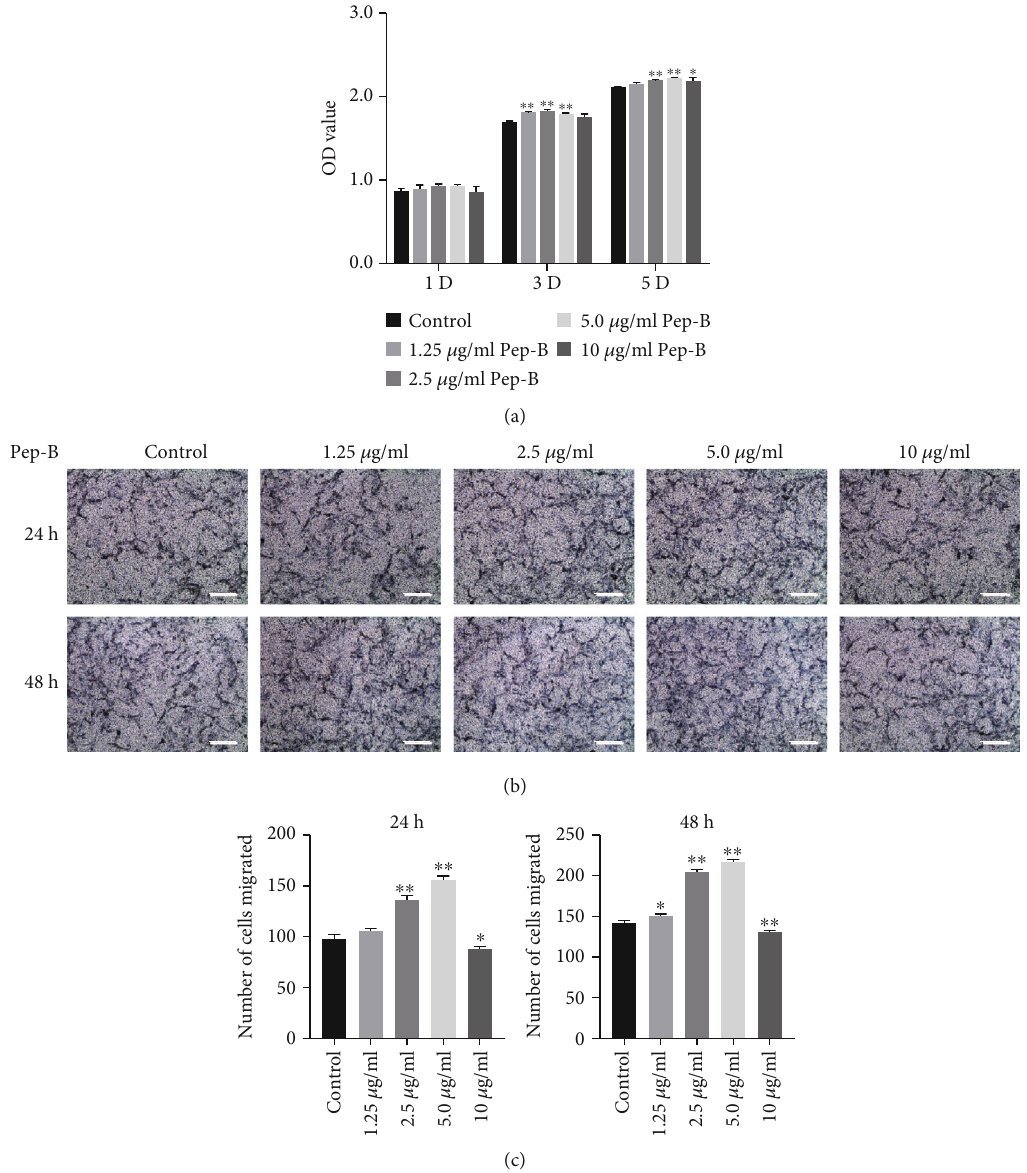
Figure 2: The e ff ects of Pep-B on cell proliferation and chemotaxis of hDPSCs. Cells were treated with a series of concentrations of Pep-B (1.25, 2.5, 5, and 10 μ g/ml). (a) Proliferation was determined by the CCK-8 assay for 1, 3, and 5 days. (b) The migratory cells from di ff erent groups were stained by crystal violet for 24 and 48 h. (c) Statistical analysis of the average migratory cell numbers per fi eld from di ff erent groups. ∗ P < 0 : 05 , ∗∗ P < 0 : 01 , ∗ represents comparison with the control group. Scale bars: 200 μ